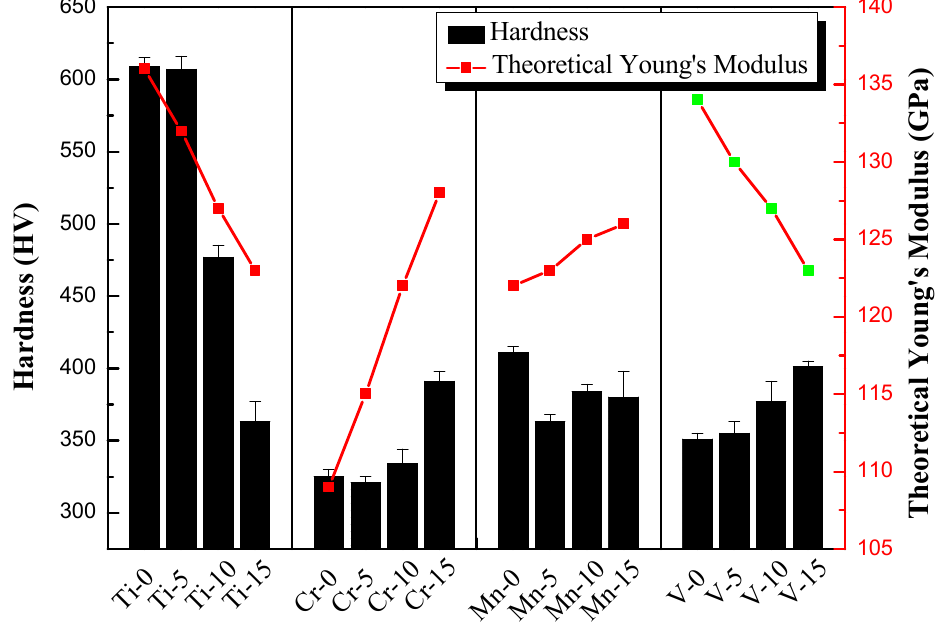
Figure 8. The relationship between hardness and theoretical Young’s modulus of Al 50 –Ti–Cr–Mn– V alloys.